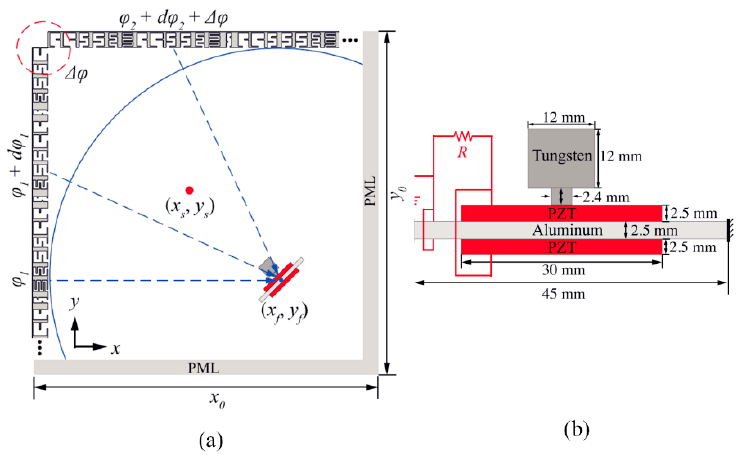
Figure 19. (a). Schematic diagram of the metasurface; the piezo beam is placed at the sound-focusing location. (b). Detailed piezo beam description. Reproduced with permission from [58]; published by American Institute of Physics, 2017.